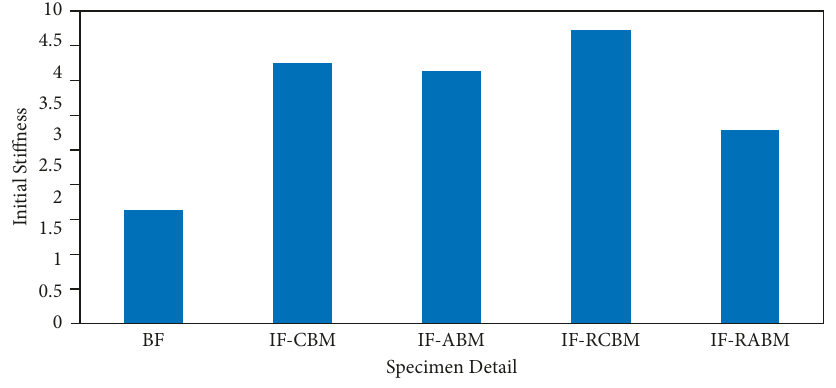
Figure 7: Initial stiffness of